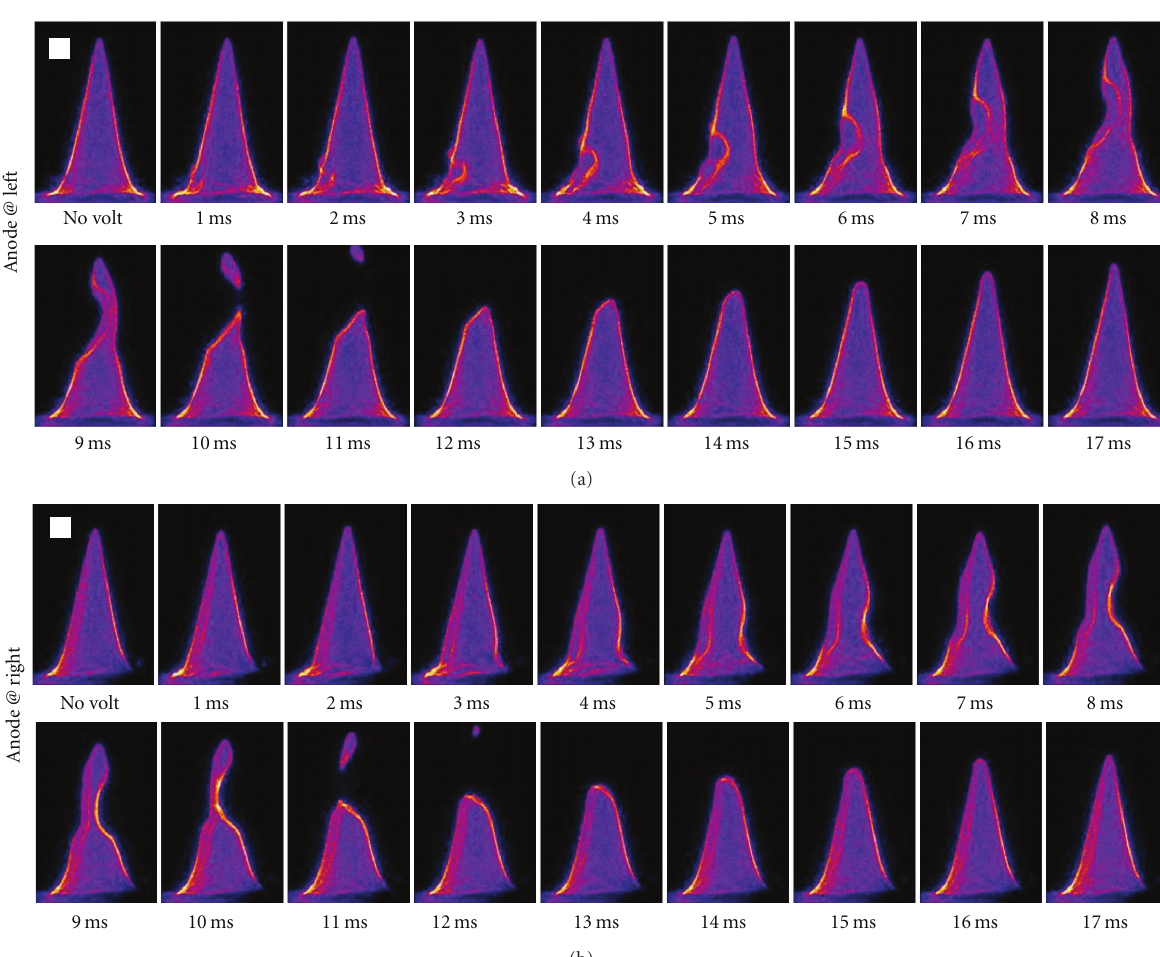
Figure 5: Sequence of CH (A-X) chemiluminescence images collected with a gated ICCD camera. This sequence shows that the onset of flame structure modification originates from a specific region at or near the cathode and not in the reaction zone of the entire flame volume. Each set shows a single distortion caused by +2.7kV applied voltage across a 3 mm gap, but di ff ers on the location of the anode. The delay shown is from the end of the 4ms applied voltage pulse. The white box in the upper left corner of each “No Volt” image is 5 mm by 5